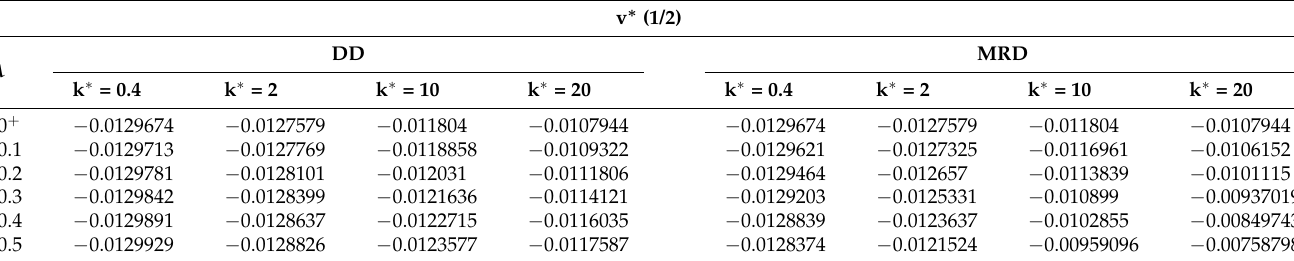
Table 6. Simply supported beam subjected to a non-dimensional uniform load q ∗ y = − 1. Non-dimensional maximum displacement v ∗ ( 1/2 ) versus the non-dimensional length-scale parameter λ evaluated by the non-dimensional Winkler parameter k ∗ ∈ { 0.4,2,10,20 } in the DD and MRD models.